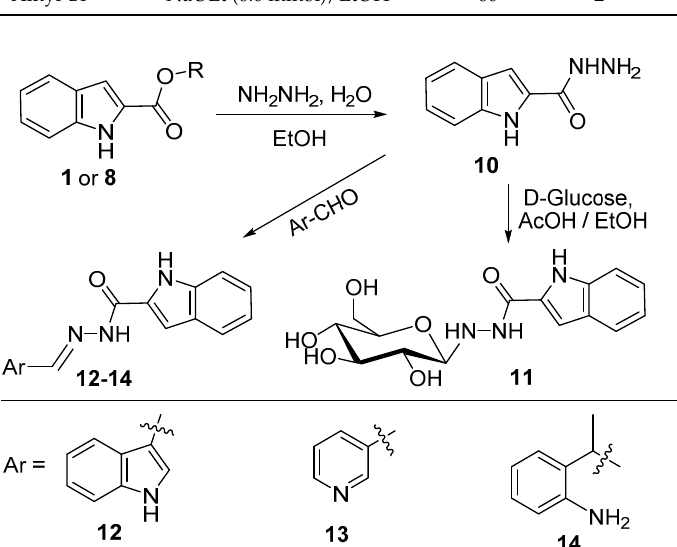
Scheme 3. Synthesis of thiazoles 17 and 18 .